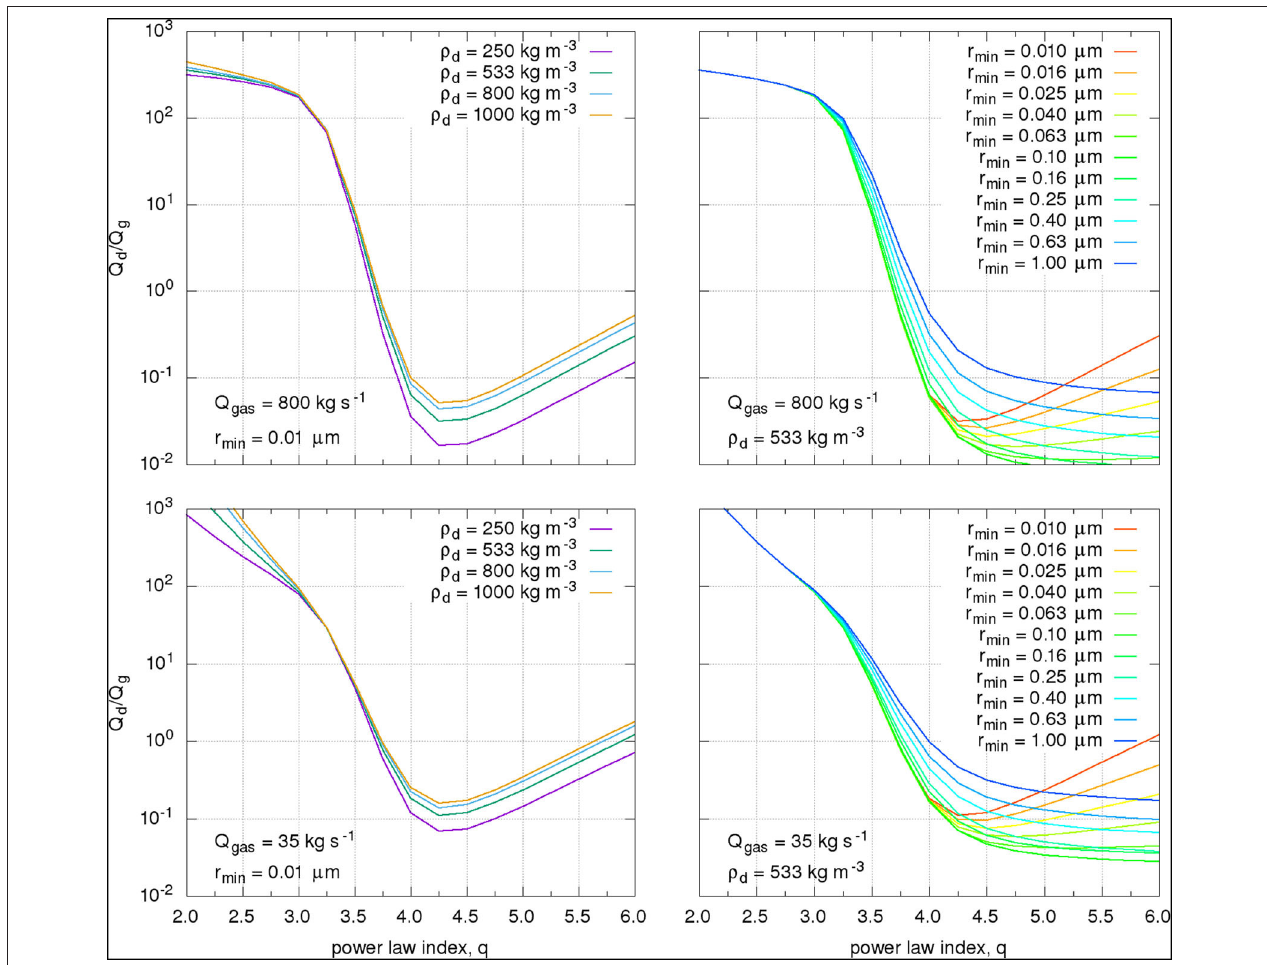
FIGURE 7 | The four panels show the dust-to-gas ration as a function of power-law index. The left two panels show the results for different bulk dust densities (250 kg m − 3 [purple], 533 kg m − 3 [green], 800 kg m − 3 [blue], 1,000 kg m − 3 [orange]) assuming a minimum dust size of 0.01 µ m and a gas production rate of 800 kg s − 1 (top panel, epoch 12) and 35 kg s − 1 (bottom panel, epoch 6). The two right panels show the results for varying minimum dust size of the power-law from 0.01 µ m (red) to 1 µ m (blue) assuming a bulk dust densities of 533 kg m − 3 and a gas production rate of 800 kg s − 1 (top panel, epoch 12) and 35 kg s − 1 (bottom panel, epoch